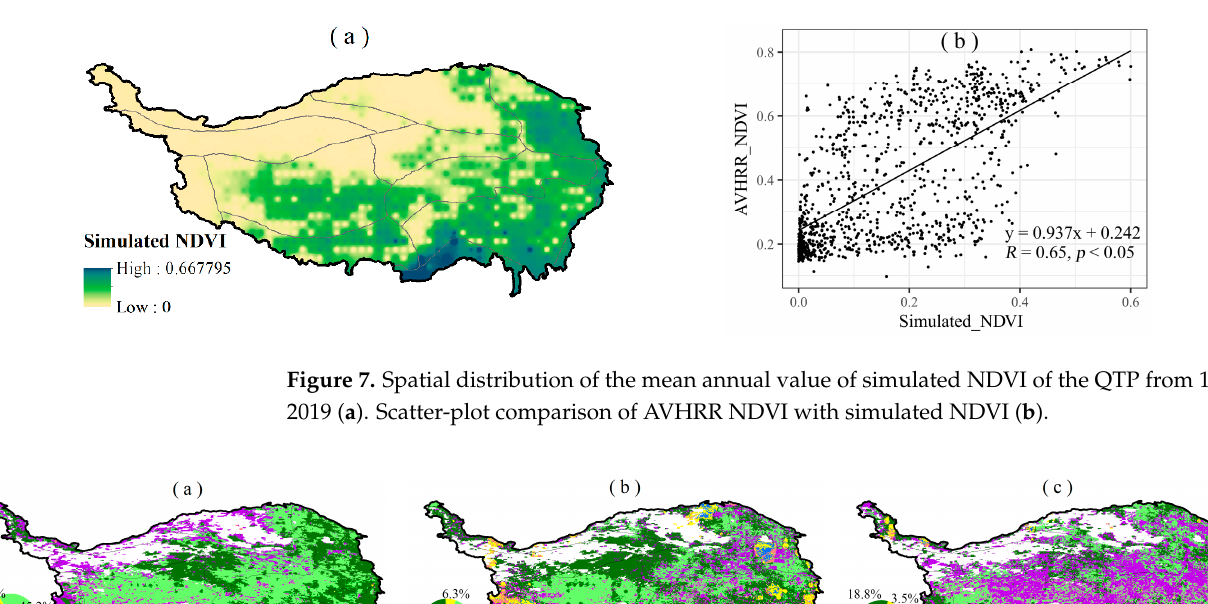
Figure 7. Spatial distribution of the mean annual value of simulated NDVI of the QTP from 1982 to 2019 ( a ). Scatter-plot comparison of AVHRR NDVI with simulated NDVI ( b ).